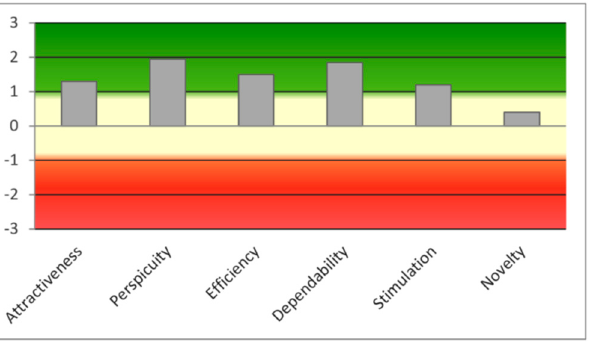
Figure 8. Evaluation of the user interface at the end of the crop cycle—extended questionnaire. Summary of the Results of the Open Question Section